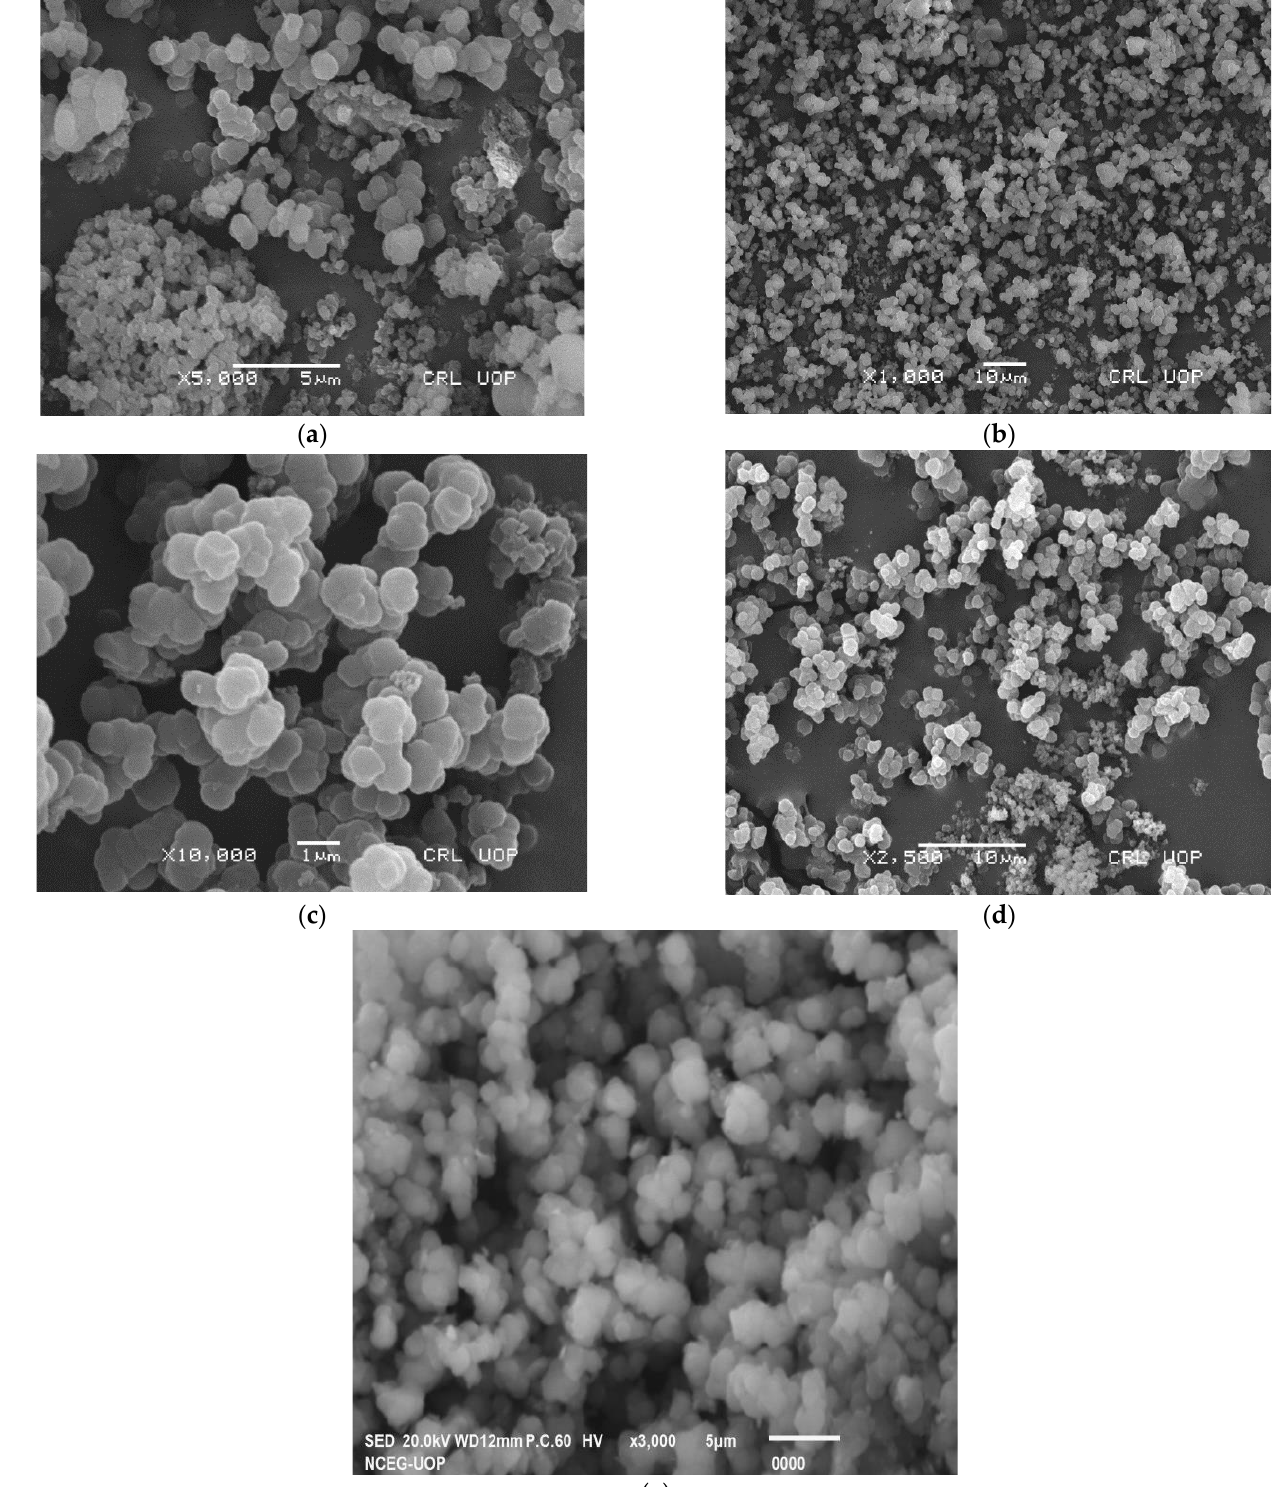
Figure 2. SEM micrographs after adsorption ( a , b ) and washing ( c , d ) of an MIP and ( e ) NIP .